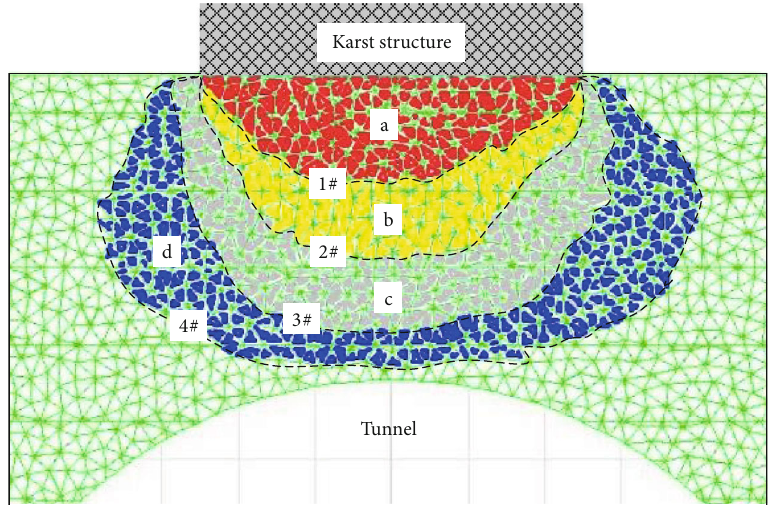
Figure 12: Degradation region iterative method based on the di ff usion range.